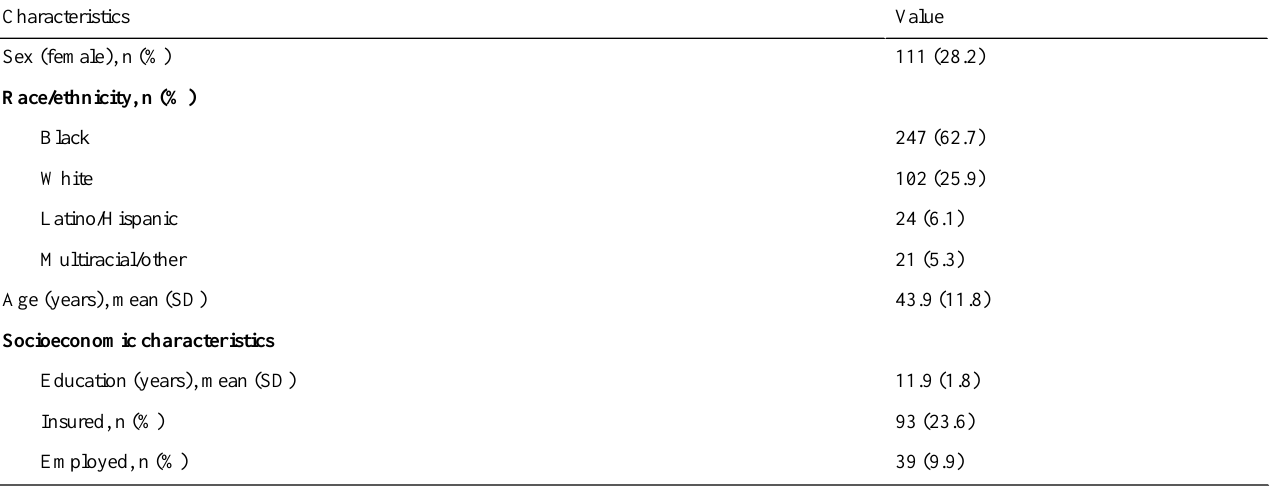
Table 1. Characteristics of people enrolled in the Bridge Homeless Recovery Program (N=394).